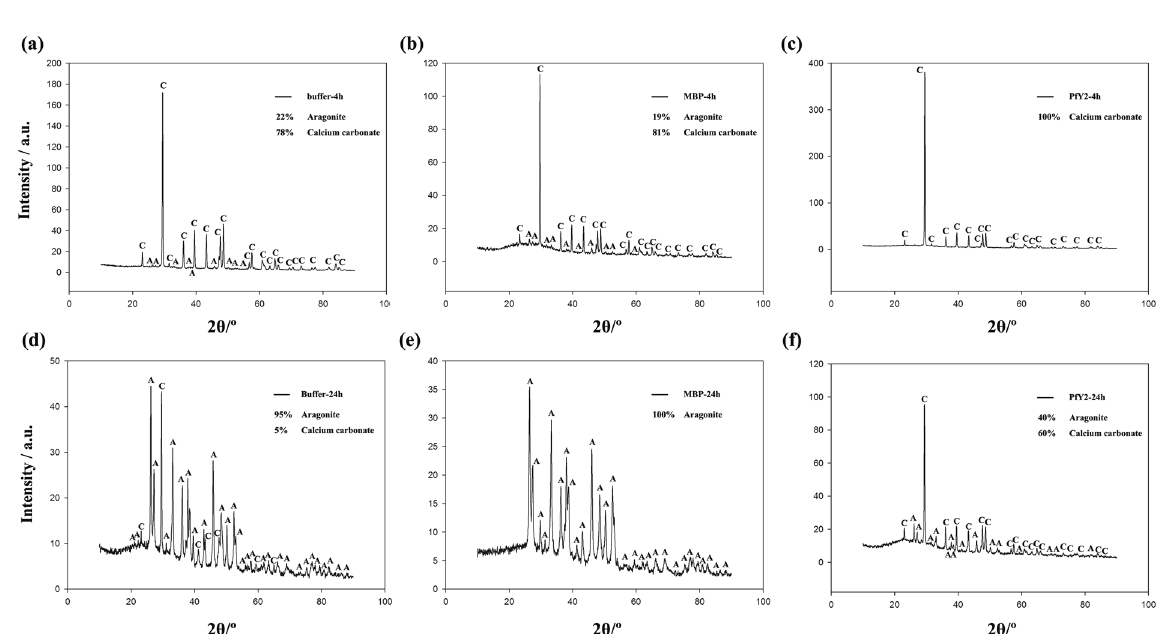
Figure 11. The effects of rPfY2 on ACC transition to aragonite. XRD was performed to detect the percentage of the crystals ACC transformed to. The final concentration of rPfY2 was 50 μ g/ml. Equivalent of MBP was added to the reaction system as